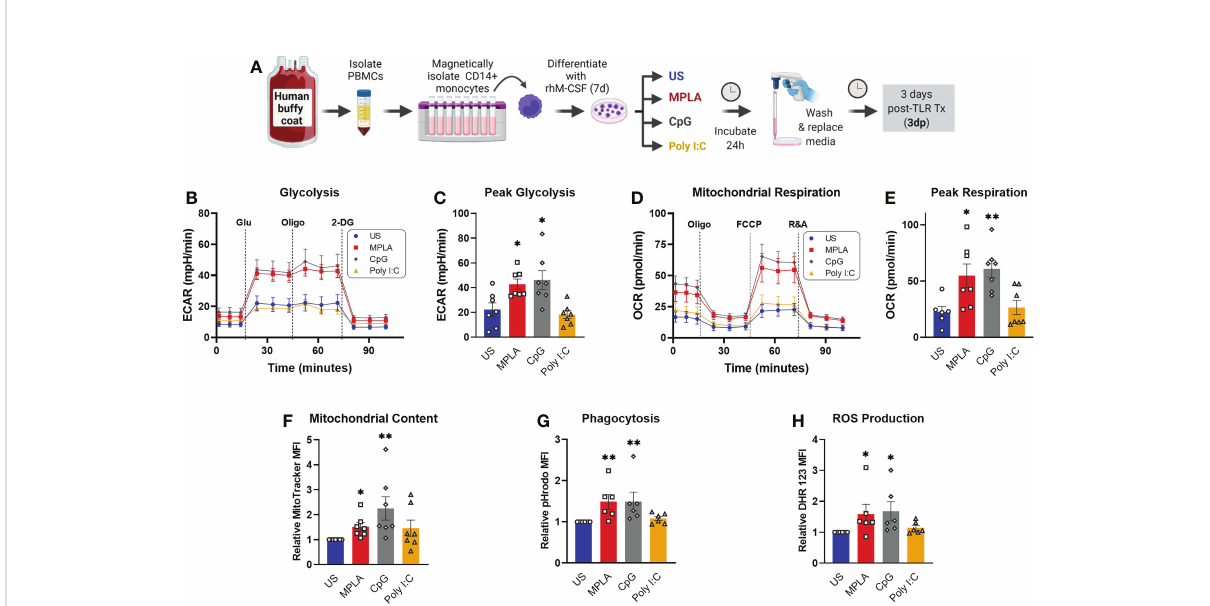
FIGURE 9 Activation of TLR/MyD88 signaling induces training in human monocyte-derived macrophages. (A) PBMCs were enriched from human buffy coat samples and monocytes were isolated using immunomagnetic CD14+ positive selection. Monocytes were differentiated for 7d with recombinant human M-CSF (rhM-CSF) resulting in human monocyte-derived macrophages (hMDMs). hMDMs were treated for 24h with MPLA (10 µg/mL), CpG (10 µg/mL), or Poly I:C (100 µg/mL) or left unstimulated (US) as negative controls. Agonist-treated hMDMs were washed, media was replaced, and cells were rested for 3 days prior to assays (i.e. 3 days post-treatment; 3dp). (B) Extracellular acidi fi cation rate (ECAR) was measured as an indicator of glycolytic capacity and (C) Peak glycolysis was analyzed. (D) Oxygen Consumption Rate (OCR) was measured and (E) peak mitochondrial respiration were analyzed. (F) Mitochondrial content was assessed by MitoTracker staining. (G) Phagocytic capacity was measured by fl uorescence of pHrodo-labeled S. aureus. (H) ROS production was determined by relative dihydrorhodamine 123 (DHR 123) fl uorescence. N=6-7/group, *p < 0.05 and **p < 0.01 by ANOVA followed by Dunnett ’ s post-hoc multiple comparison test.